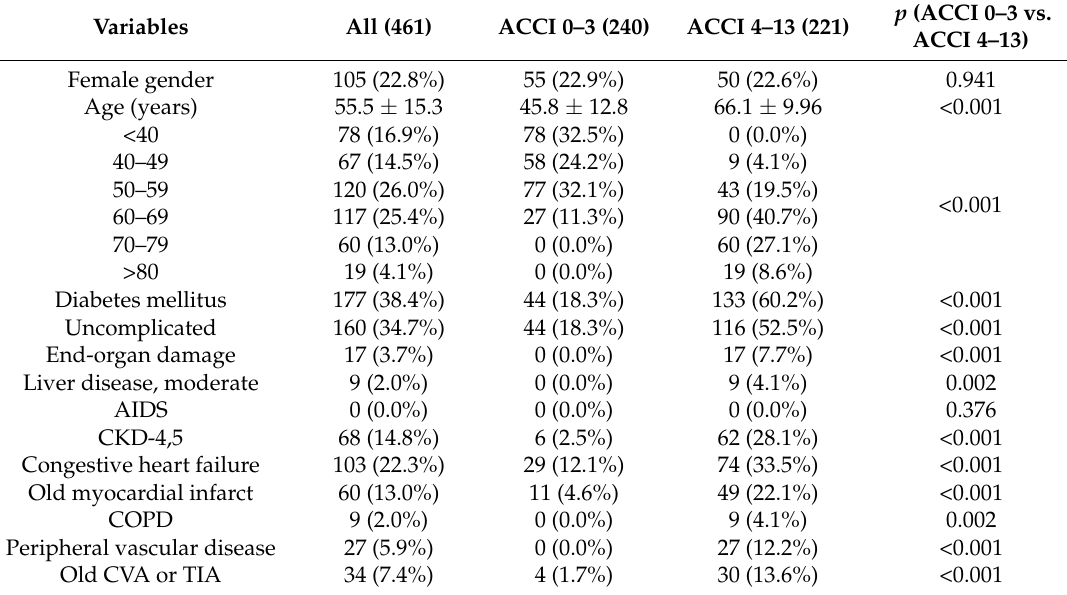
Figure 2. Histogram of the ( A ) Charlson comorbidity index (CCI); ( B ) age; and ( C ) age-adjusted Charlson comorbidity index (ACCI) for the study patients. ECPR: extracorporeal cardiopulmonary resuscitation. Table 1. Demographic and clinical data of the study patients grouped by ACCI before the ECPR index.